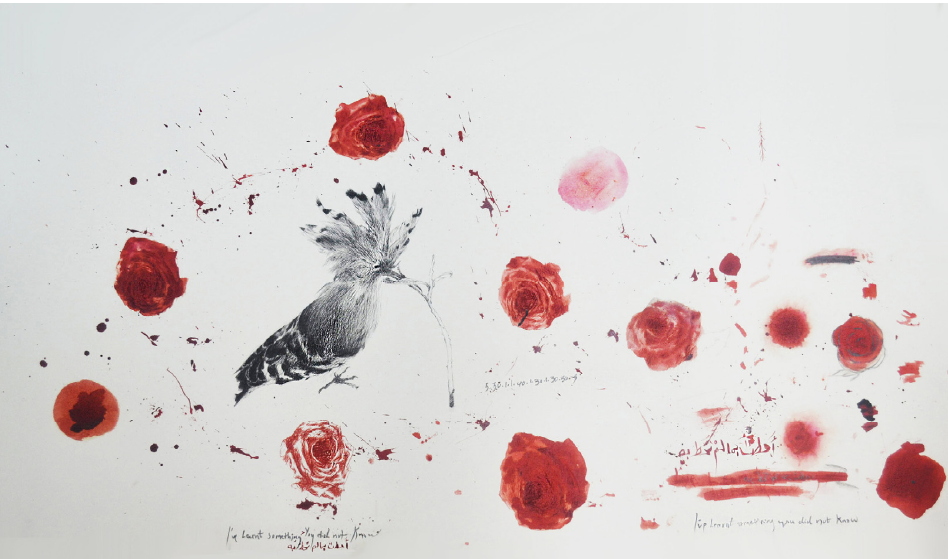
Figure 11. Hanaa Malallah, I Have Learnt Something You Did Not Know, 2015. Black and red ink on paper. 60 × 100 cm. © Hanaa Malallah.